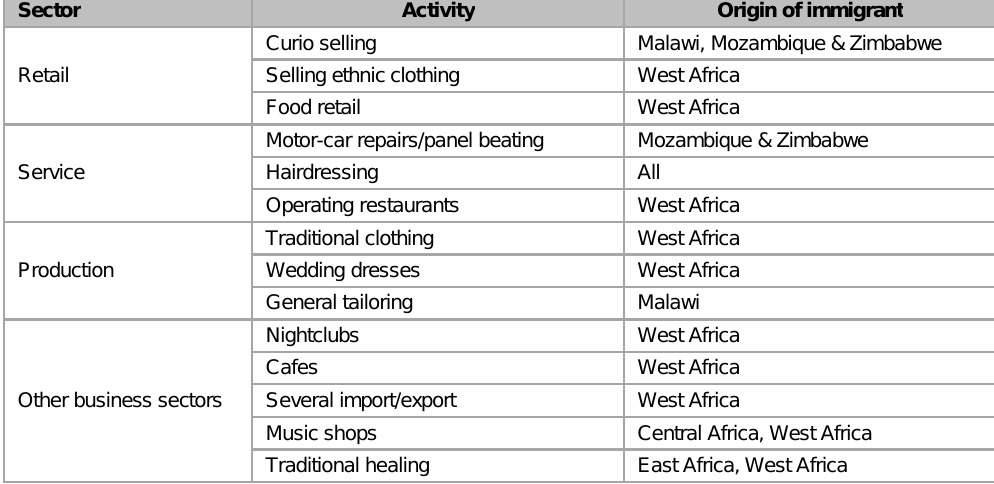
Immigrants’ business clusters according to their origins